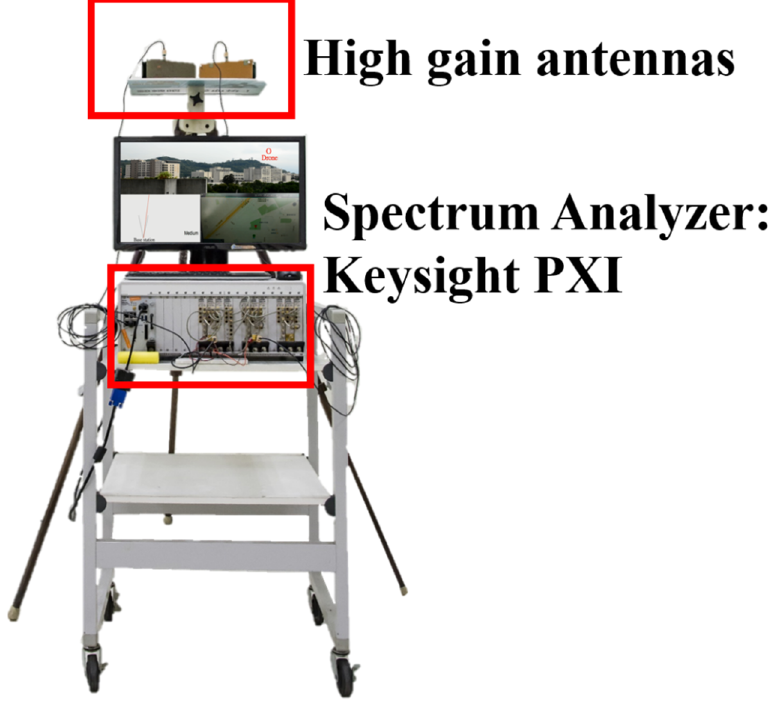
Figure 11. The antennas and spectrum analyzer used in the base station.